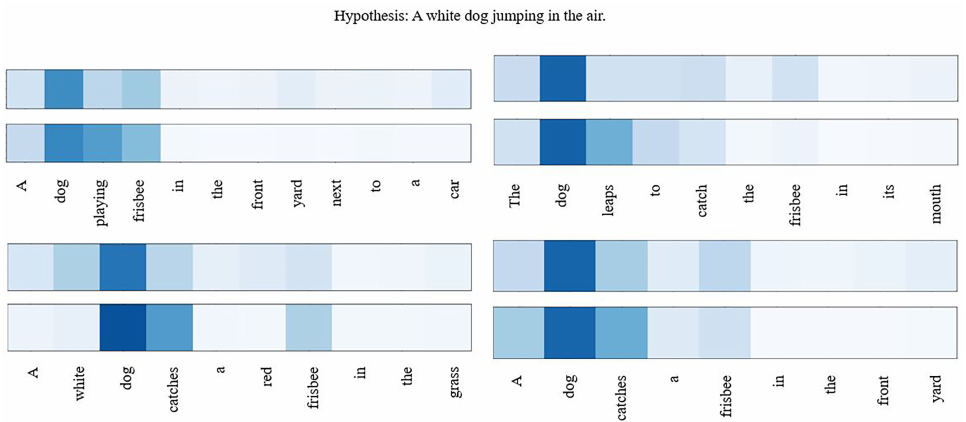
Figure 7. Attention visualizations.